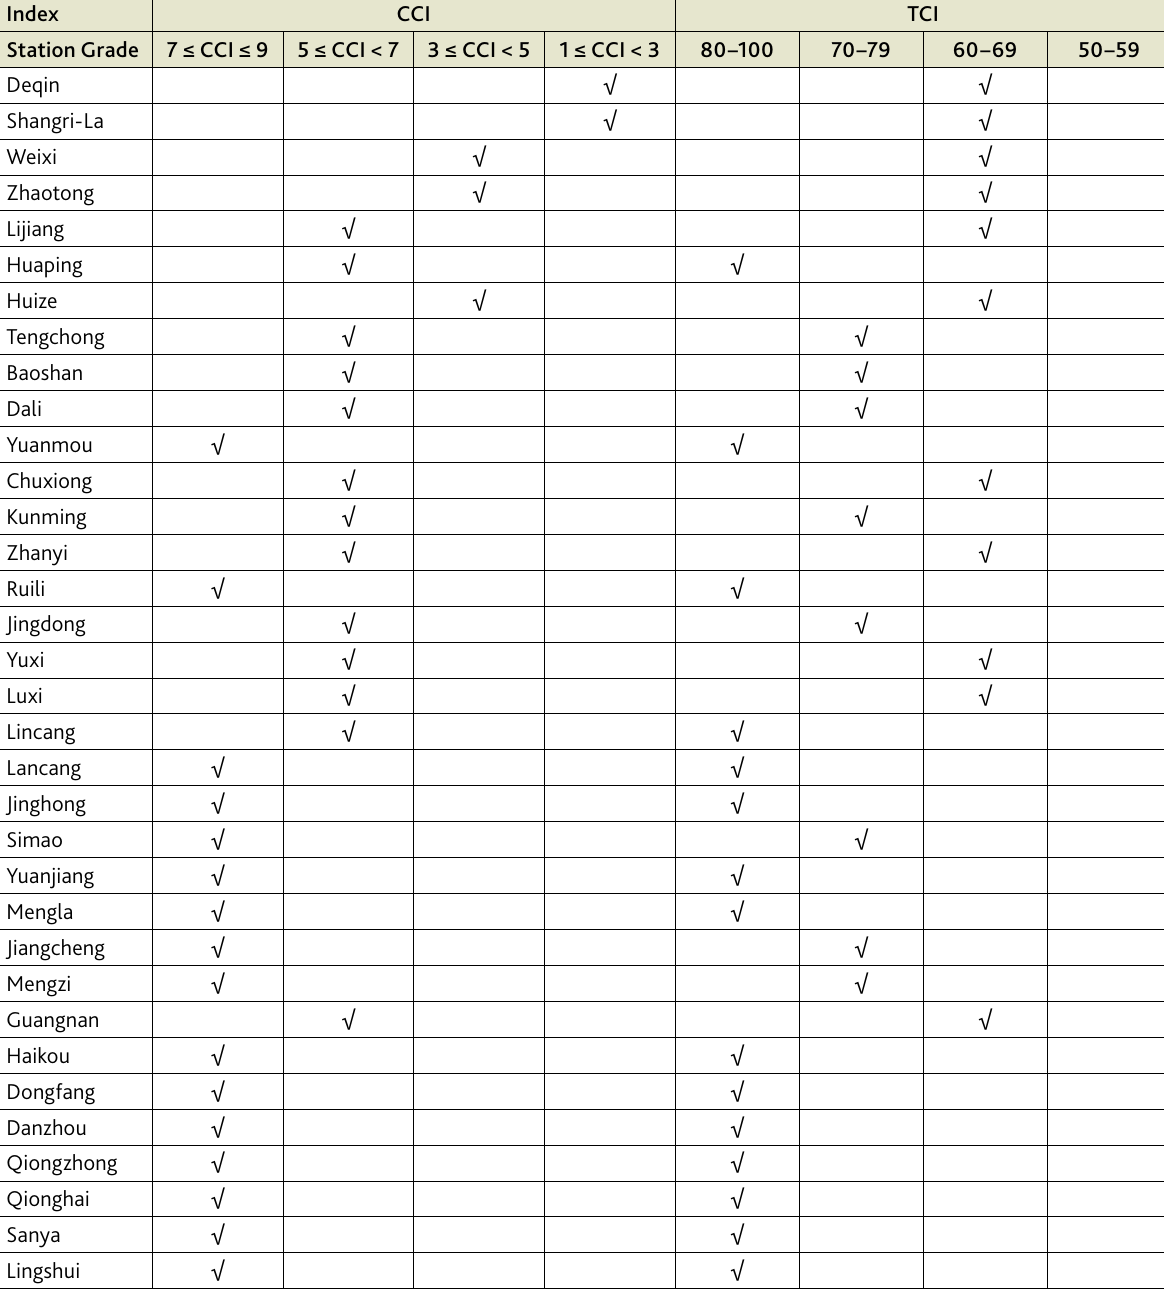
Table 3. December CCI and TCI classifications for Yunnan (first 27 stations) and Hainan (last 7 stations) provinces between 1981 and